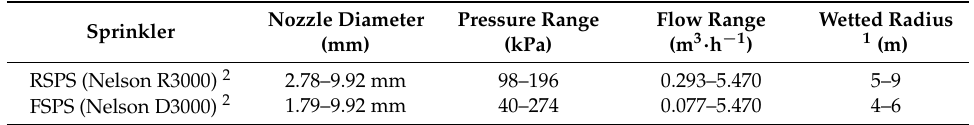
Table 1. Basic performance parameters of rotating and fixed spray plate sprinklers (RSPSs and FSPSs).